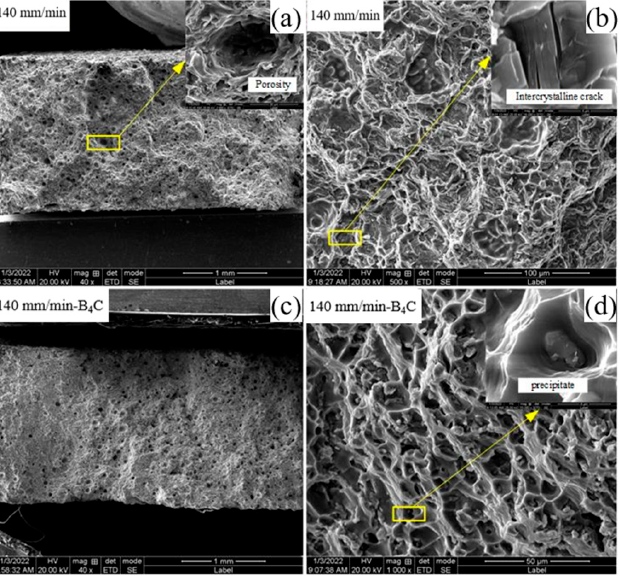
Figure 14. Fracture profile of deposited aluminum alloy tensile specimens in transverse direction ( a , b ) 140 mm/min, ( c , d ) 140 mm/min-B 4 C .